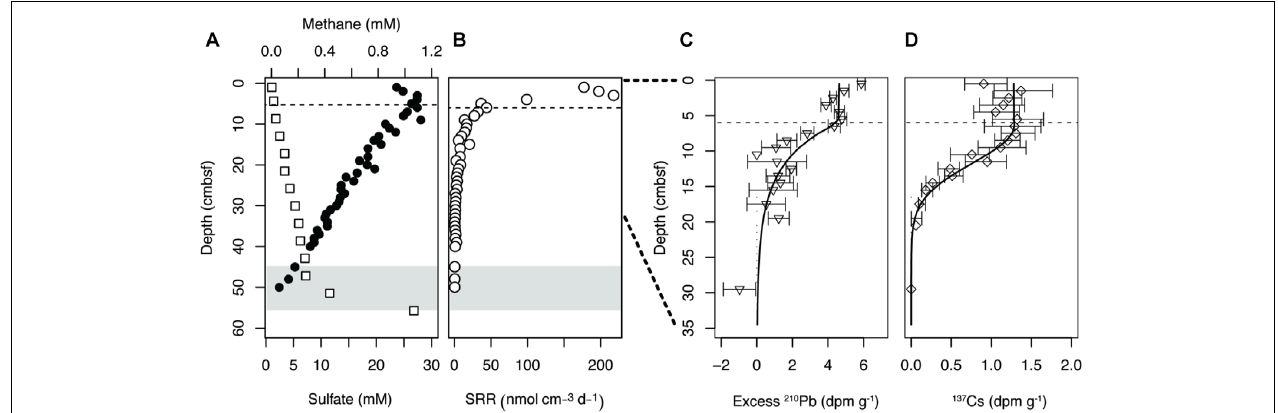
FIGURE 1 | (A) Geochemical zonation of site M5, Aarhus Bay (Denmark). The sulfate profile ( • ) was measured in the present study, while the methane profile ( (cid:3) ) was obtained from previous work at the same site (H R, unpublished). (B) Sulfate reduction rates (SRR). (C) Profile of excess 210 Pb and (D) 137 Cs in the surface of site M5. Error bars represent 1 sigma standard deviation of gamma counting uncertainty. Gray shading indicates the onset of the sulfate methane transition (SMT). The dashed lines indicate the bottom of the highly mixed surface layer, or bioturbation zone, based on modeling of excess 210 Pb and 137